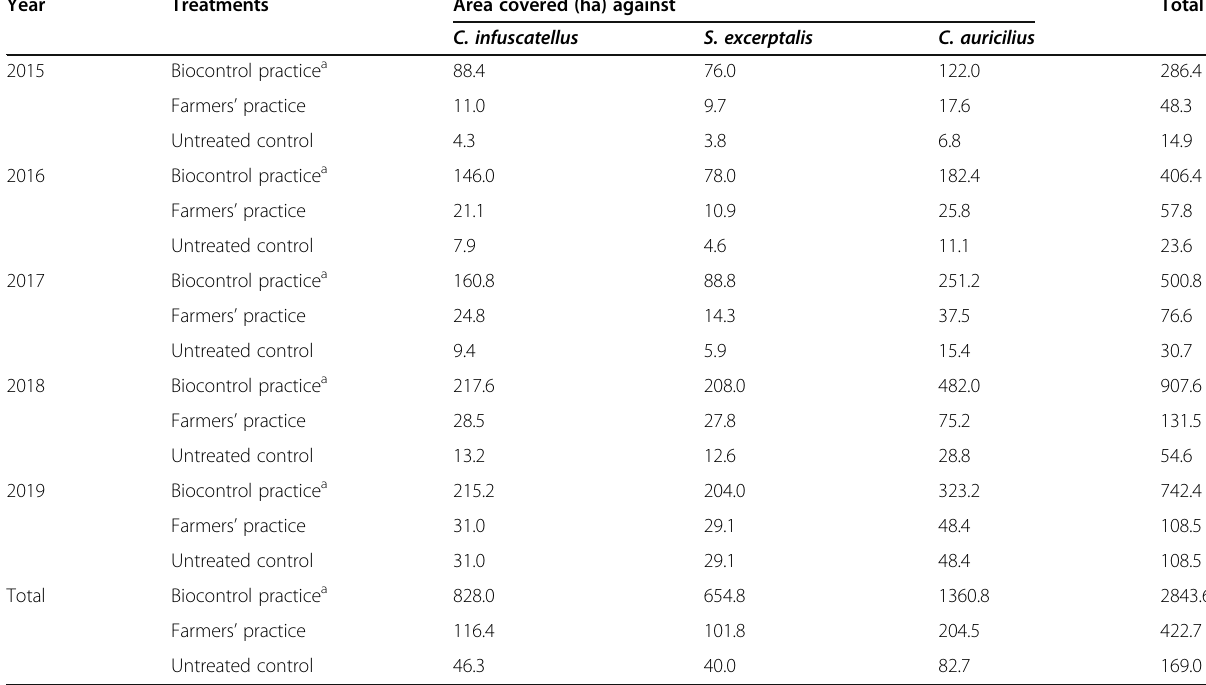
Table 1 Area covered against various sugarcane borers at farmers ’ fields during different years Year